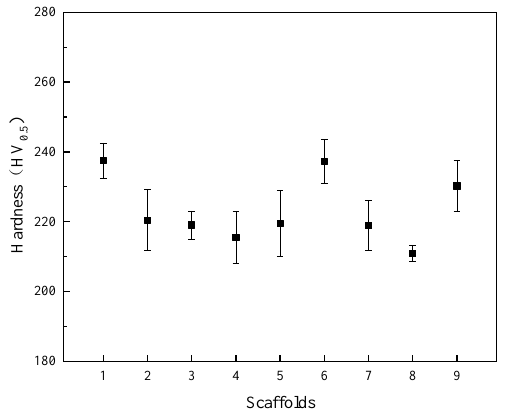
Figure 15. Microhardness of porous bone scaffolds.